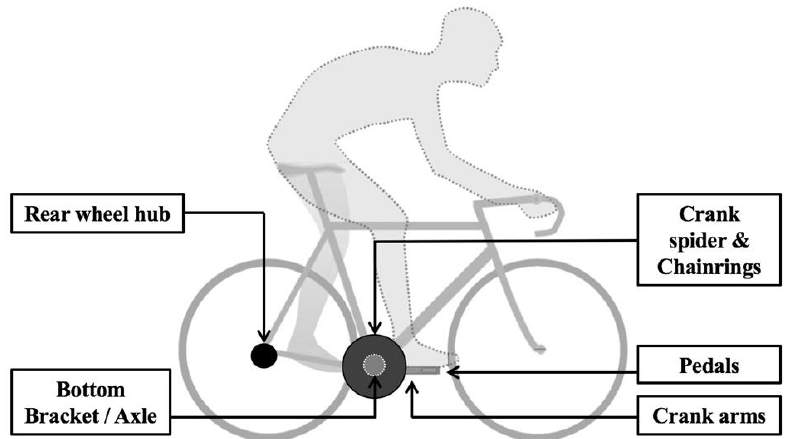
Figure 1. Schematic illustration of power meters’ location on the